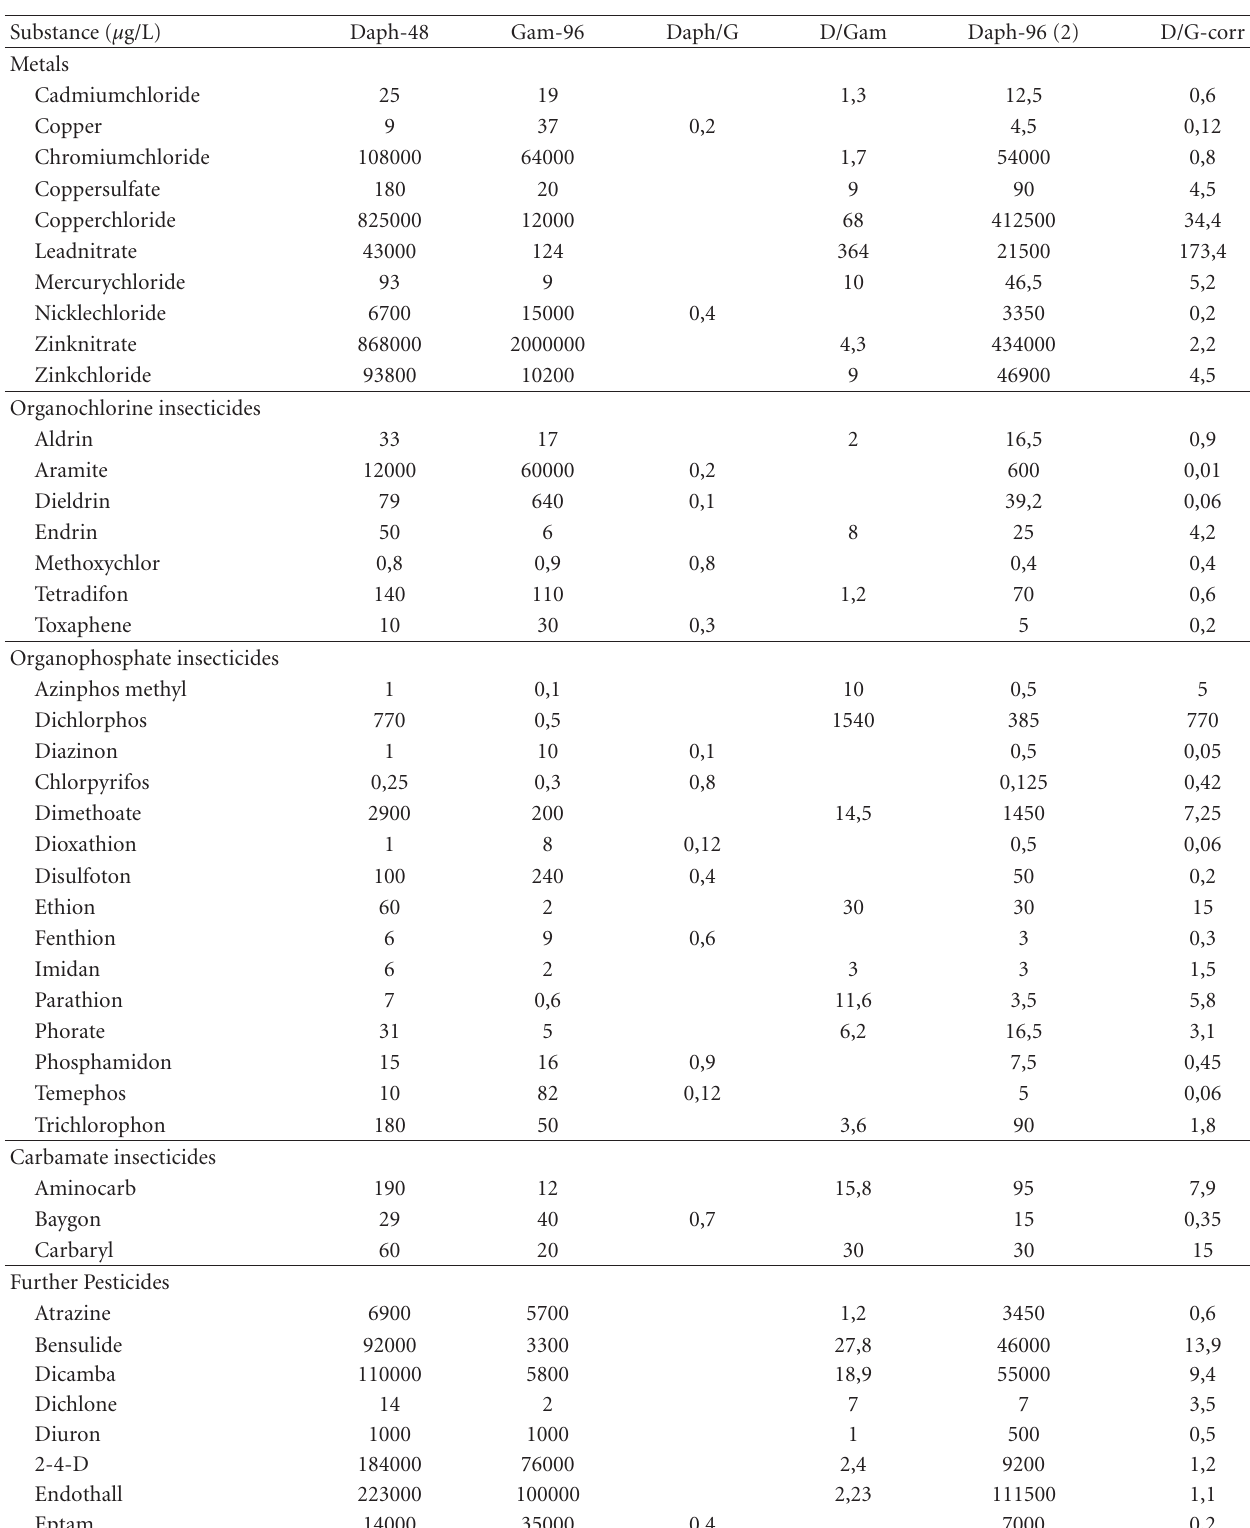
Table 1: Comparison of sensitivity of Daphnia magna and Gammarus spp. towards di ff erent types of chemicals. Daph-48: LC 50 -48h for Daphnia magna ; Gam-96: LC 50 -96h for Gammarus spp. Daph/G: ratio LC 50 Daphnia /LC 50 Gammarus , where Daphnia proved more sensitive, that is, ratio below 1. D/Gam: ratio LC 50 Daphnia /LC 50 Gammarus , where Gammarus proved more sensitive, that is,